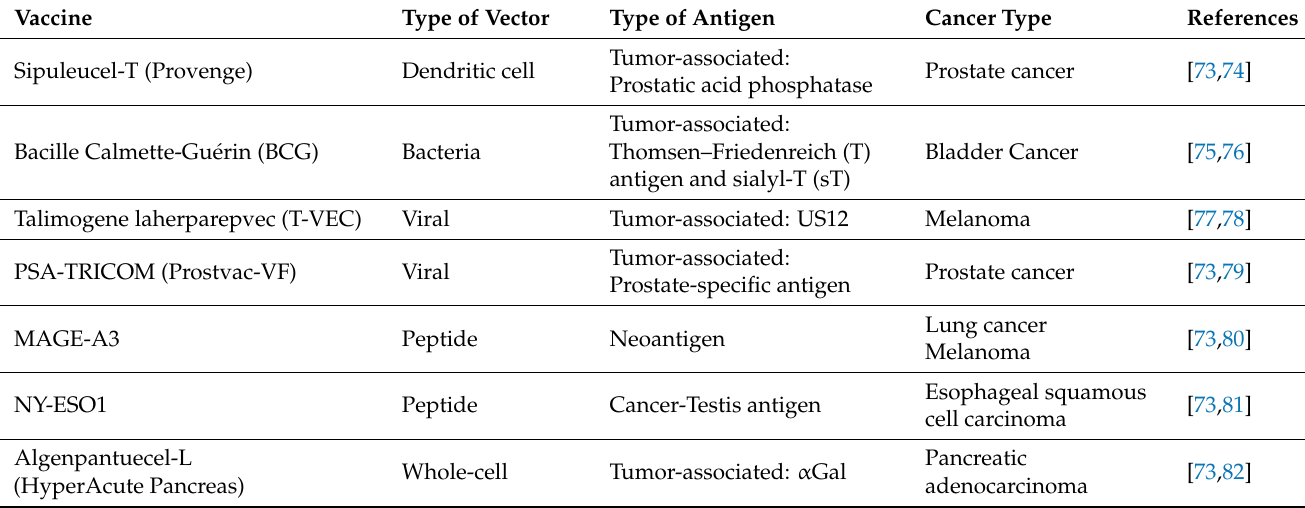
Table 1. List of therapeutic